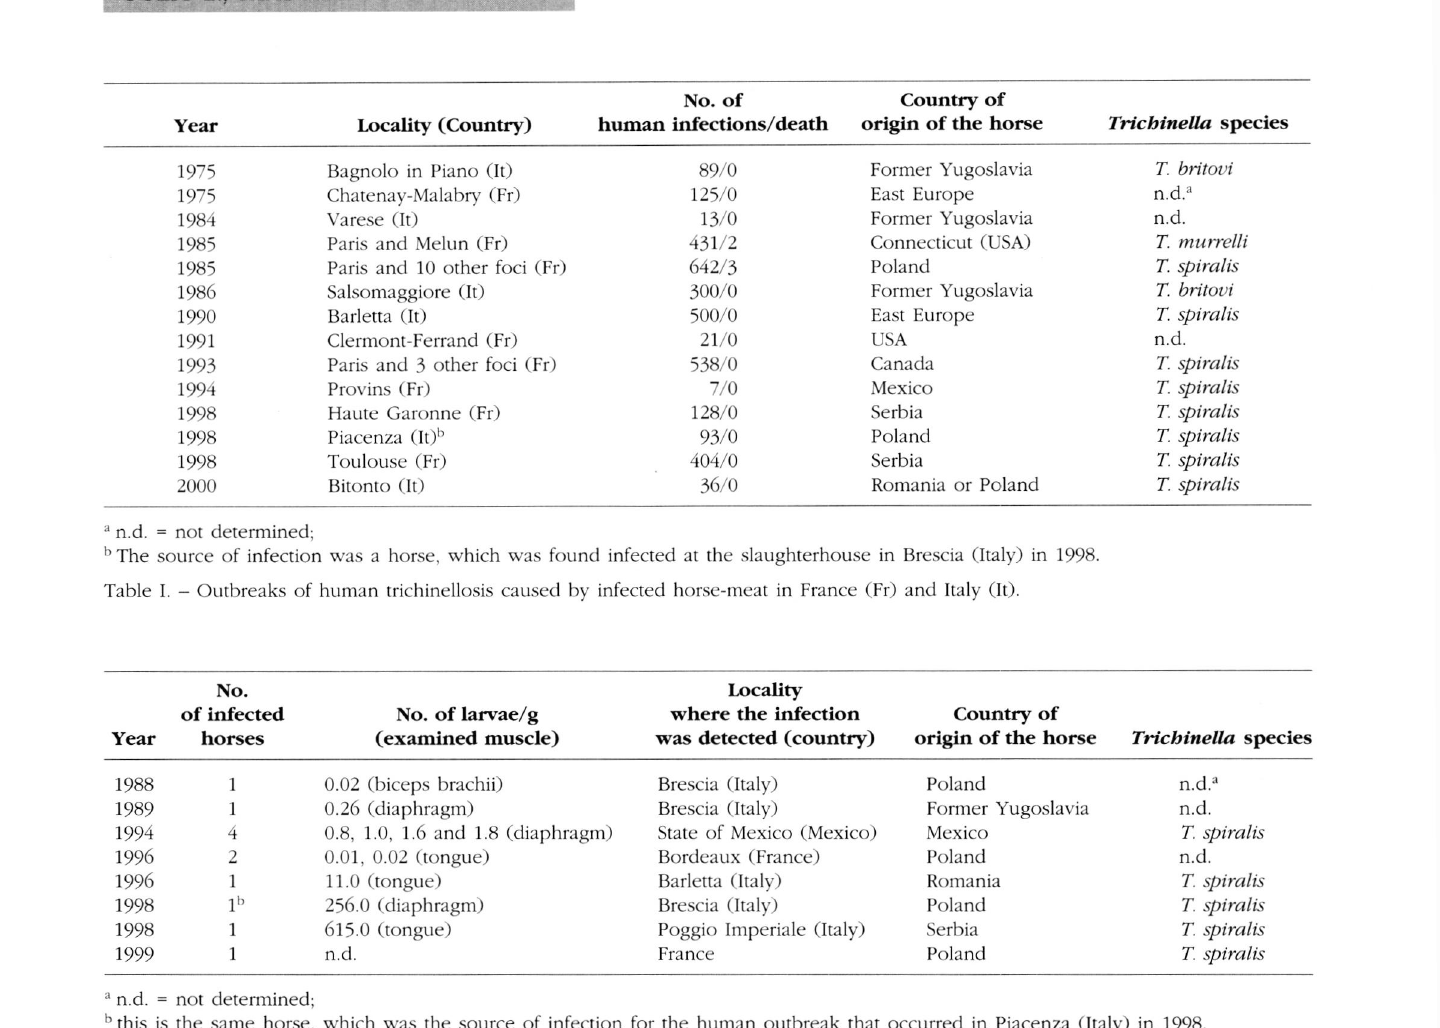
Table II. - Natural Trichinella infections detected in horses at the slaughterhouse during surveys (in Italy between 1988 and 1989; in Mexico in 1994) or during routine examinations.